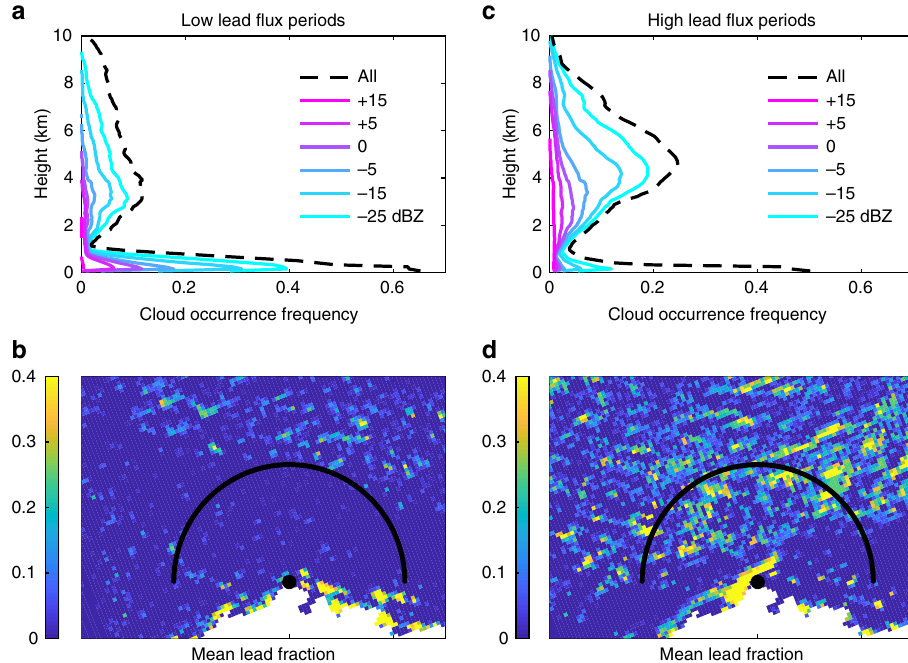
Fig. 1 MMCR derived cloud occurrence frequency and the corresponding mean lead fraction. a The vertical frequency distribution of cloud occurrence as a function of minimum re fl ectivity (dBZ) for the low lead fl ux periods. b Mean lead fraction based on AMSR-E data for four representative low lead fl ux periods in February 2011 (days 14, 15, 26, 27). c The same as a but for the high lead fl ux periods. d The same as b but for four representative high lead fl ux periods in February 2010 (days 19, 22, 23, 24). The coastal region of Alaska is shown in white, Barrow is indicated by a fi lled black circle, and the top of the 200-km radius semicircle is directed north.